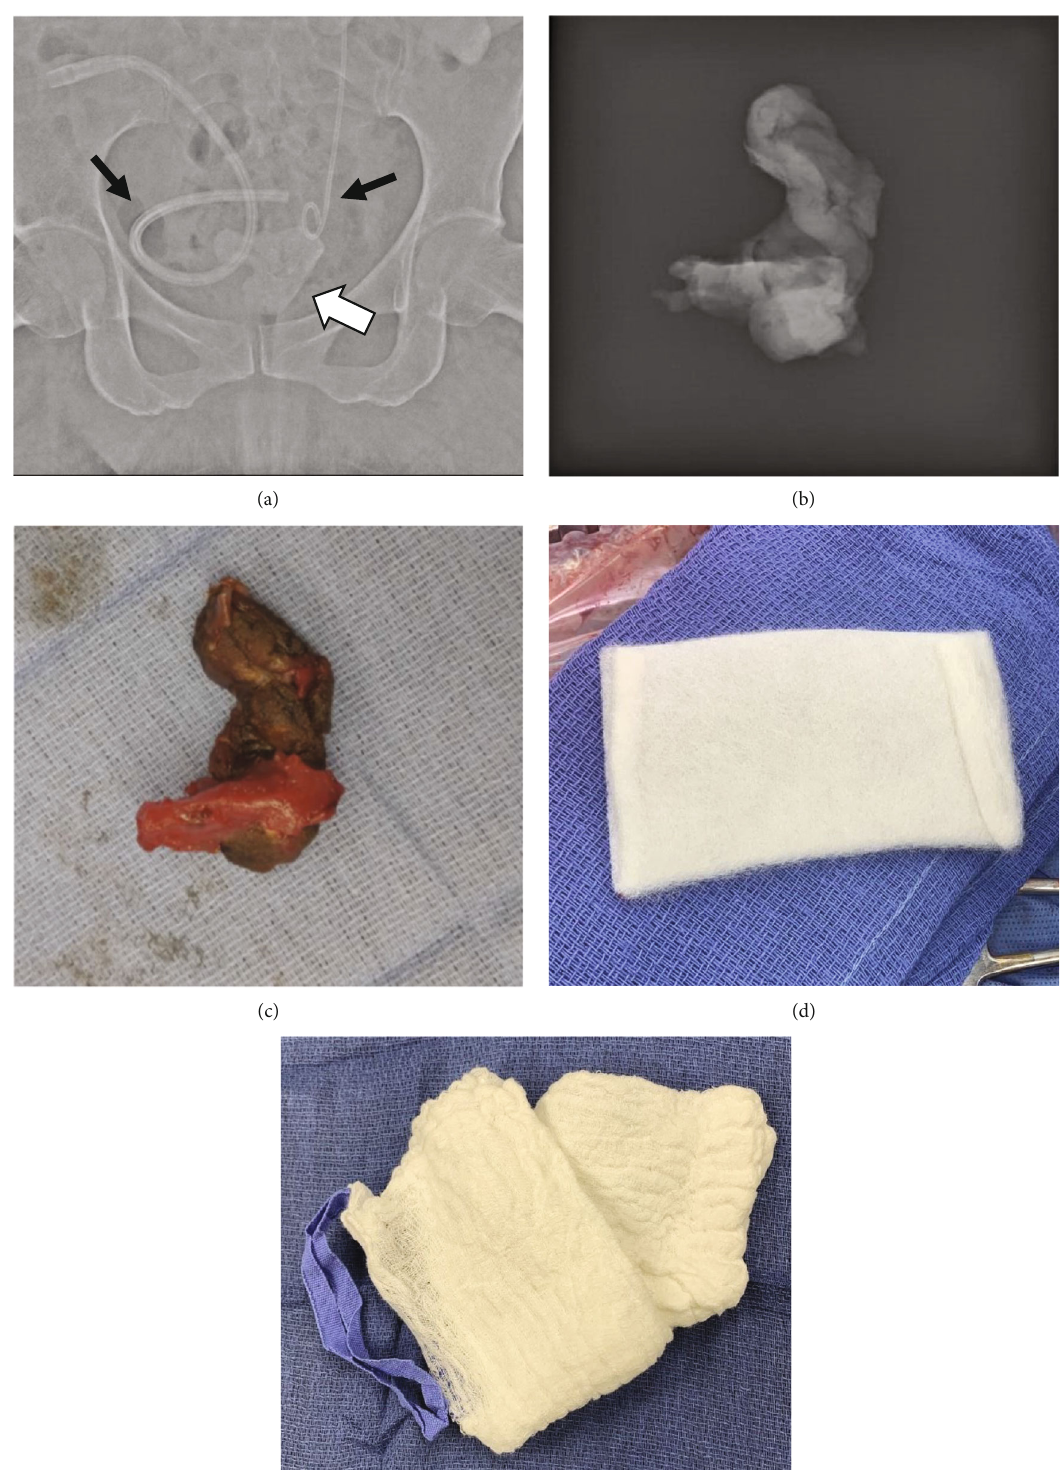
Figure 1: (a) Abdominal radiograph of patient prior to reexploration (white arrow indicates abnormal radiolucency which provoked exploration). Black arrows note the presence of a Jackson-Pratt drain (left) and ureteral stent (right) immediately adjacent to the radiolucent mass of oxidized regenerated cellulose. (b) Radiograph of nonwoven oxidized regenerated cellulose after its removal from the patient. (c) Color photograph of oxidized regenerated cellulose removed from patient ’ s pelvis (1 × magni fi cation). (d) Color photograph of fresh oxidized regenerated cellulose (1 × magni fi cation). (e) Color photograph of an unused laparotomy pad (1/2 × magni fi